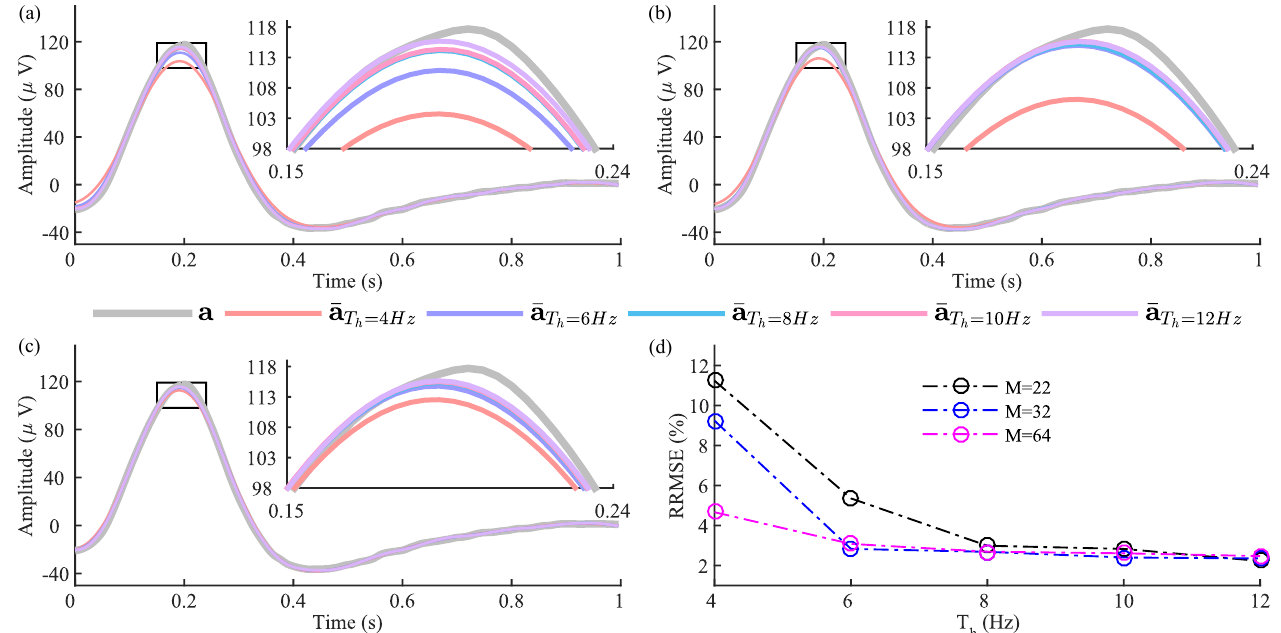
Figure 3. The estimated eye-blink artifacts ¯ a (the artifact region only) by SSA with different thresholds and the window lengths ( a ) M = 22, ( b ) M = 32, and ( c ) M = 64. ( d ) Performance of SSA in terms of RRMSE for varying window length M and thresholds ( f = 4,6,8,10 and 12 Hz). The RRMSEs were calculated with respect to the ground truth eye-blink signal, a